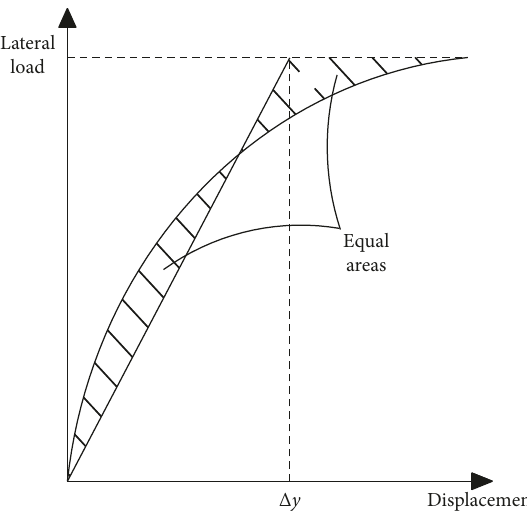
Figure 9: Definition of yield